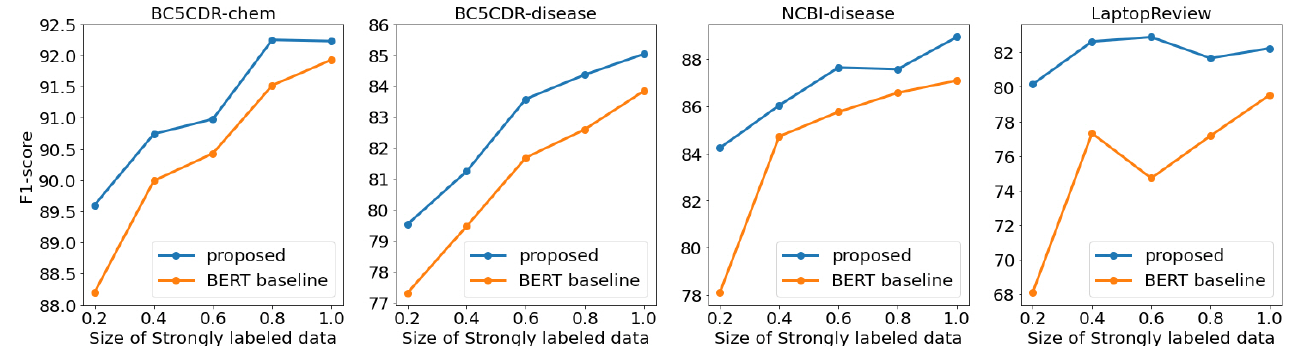
Figure 6. The trends of the test set’s span-level F1-score according to the size of the strongly labeled dataset. We described detailed numbers in Appendix A.